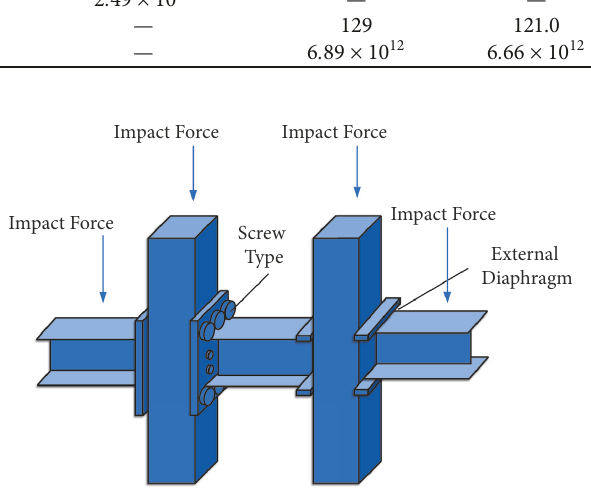
Figure 4: Schematic diagram of the direction of the impact